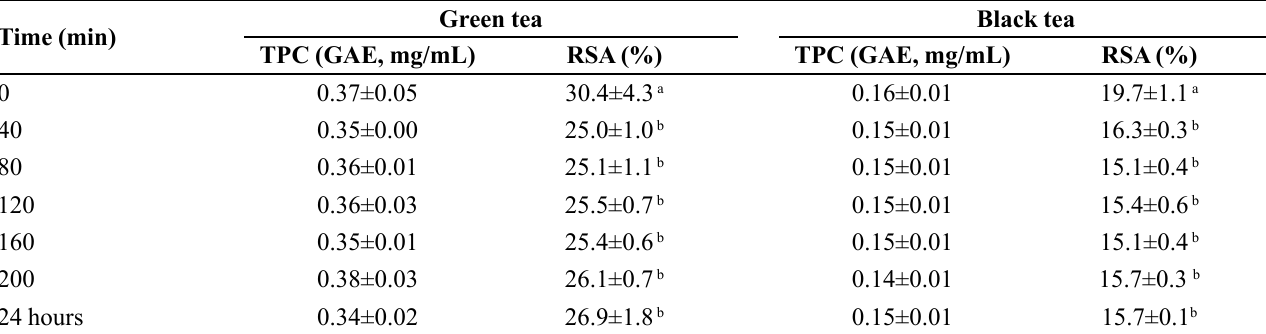
Each uncertainty represents the standard deviation of the mean of three experiments (each with five replicates), mean ± SD. No significant statistical differences (p > 0.05) were found between the TPC values, for each tea. Different letters for RSA column are indicative of significant statistical differences between the values with at least p < 0.05 (ANOVA, Tukey’s test). GAE: Data expressed as gallic acid equivalents. RSA: Data expressed as percentage inhibition of the DPPH